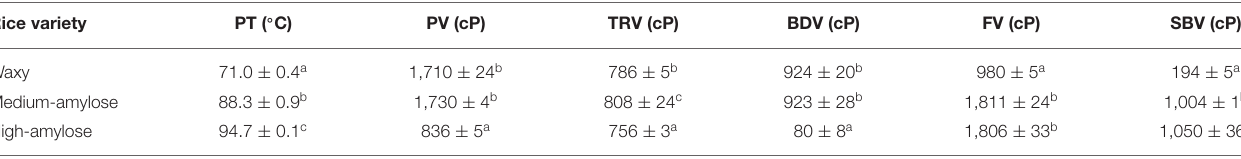
TABLE 2 | Rapid visco-analyzer (RVA) parameters of raw black rice with different amylose contents † . Rice variety